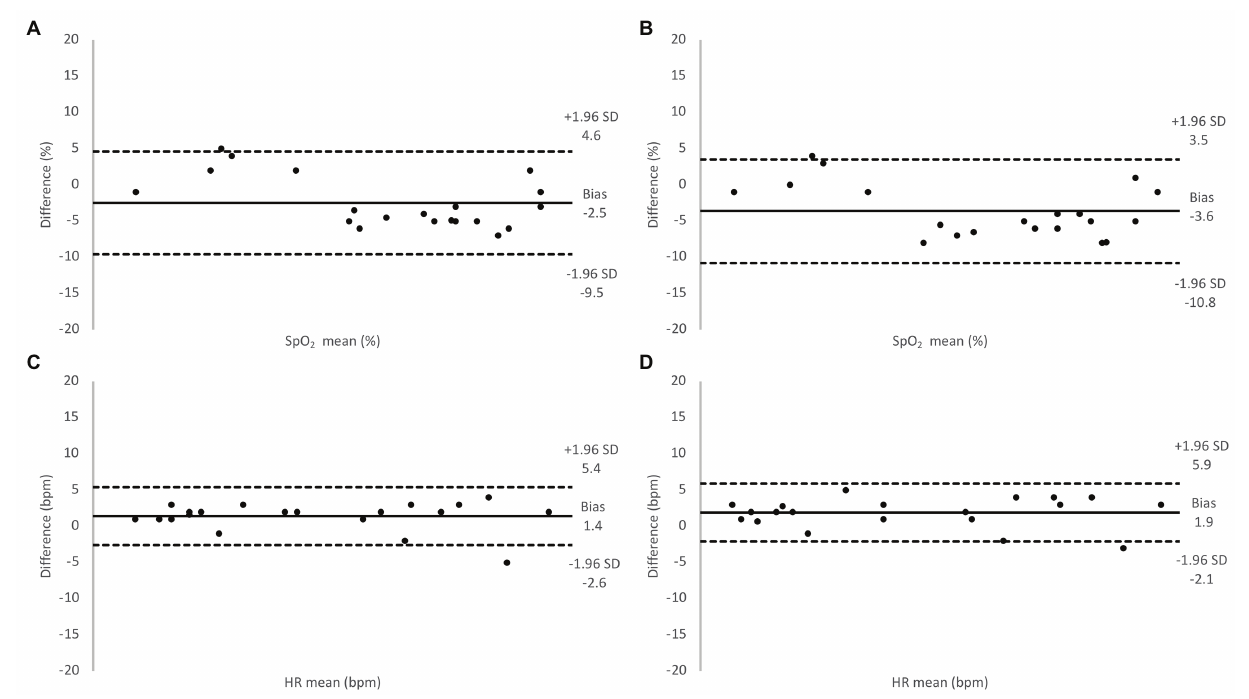
FIGURE 6 | Relative difference between oxygen saturation (SpO 2 ) values measured using the Masimo pulse oximeter and the SUB pulse oximeter (A) , the Lifesense pulse oximeter and the SUB pulse oximeter (B) , and for HR values measured using the Masimo pulse oximeter and the SUB pulse oximeter (C) , the Lifesense pulse oximeter and the SUB pulse oximeter (D) , under hypoxic